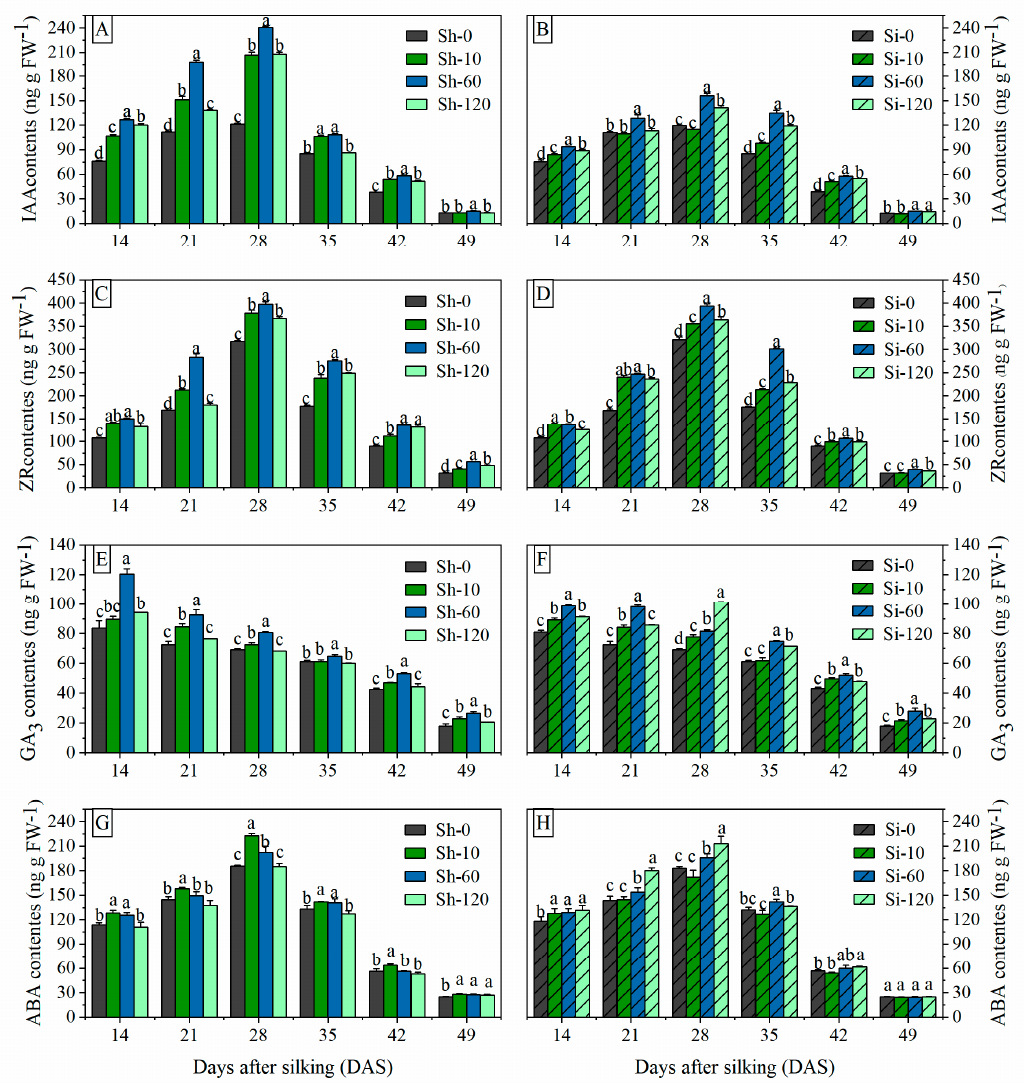
Figure 3. E ff ects of GA 4 + 7 applications on IAA, ZR, GA3 and ABA contents in maize. Sh-0, Sh-10, Sh-60 and Sh-120 represent shank-treatments with GA 4 + 7 at the rates of 0, 10, 60, and 120 mg L − 1 , respectively. Si-0, Si-10, Si-60 andSi-120 represent silk-treatments with GA 4 + 7 at the rates of 0, 10, 60, and 120 mg L − 1 , respectively. The vertical bars represent the ± the standard error of the mean (n = 3).